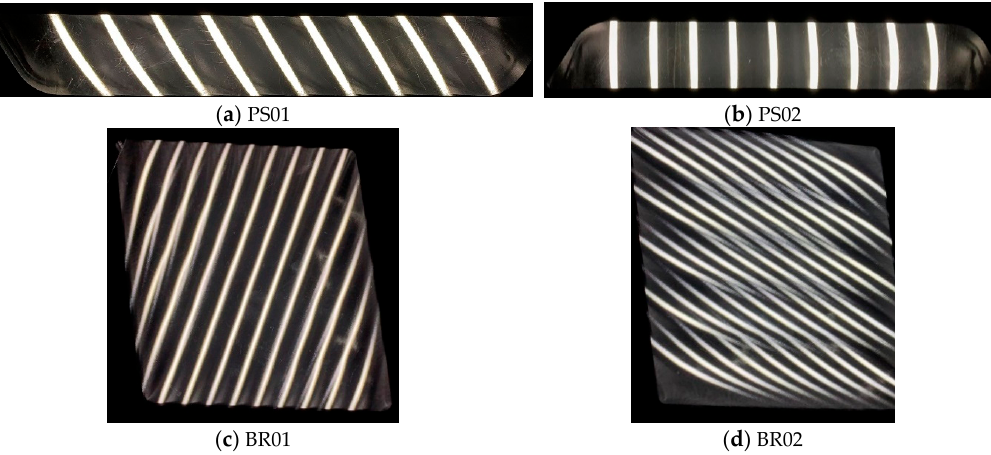
Figure 17. The light output pattern ( a , b ) postion lamps ; ( c , d ) braking lamps.